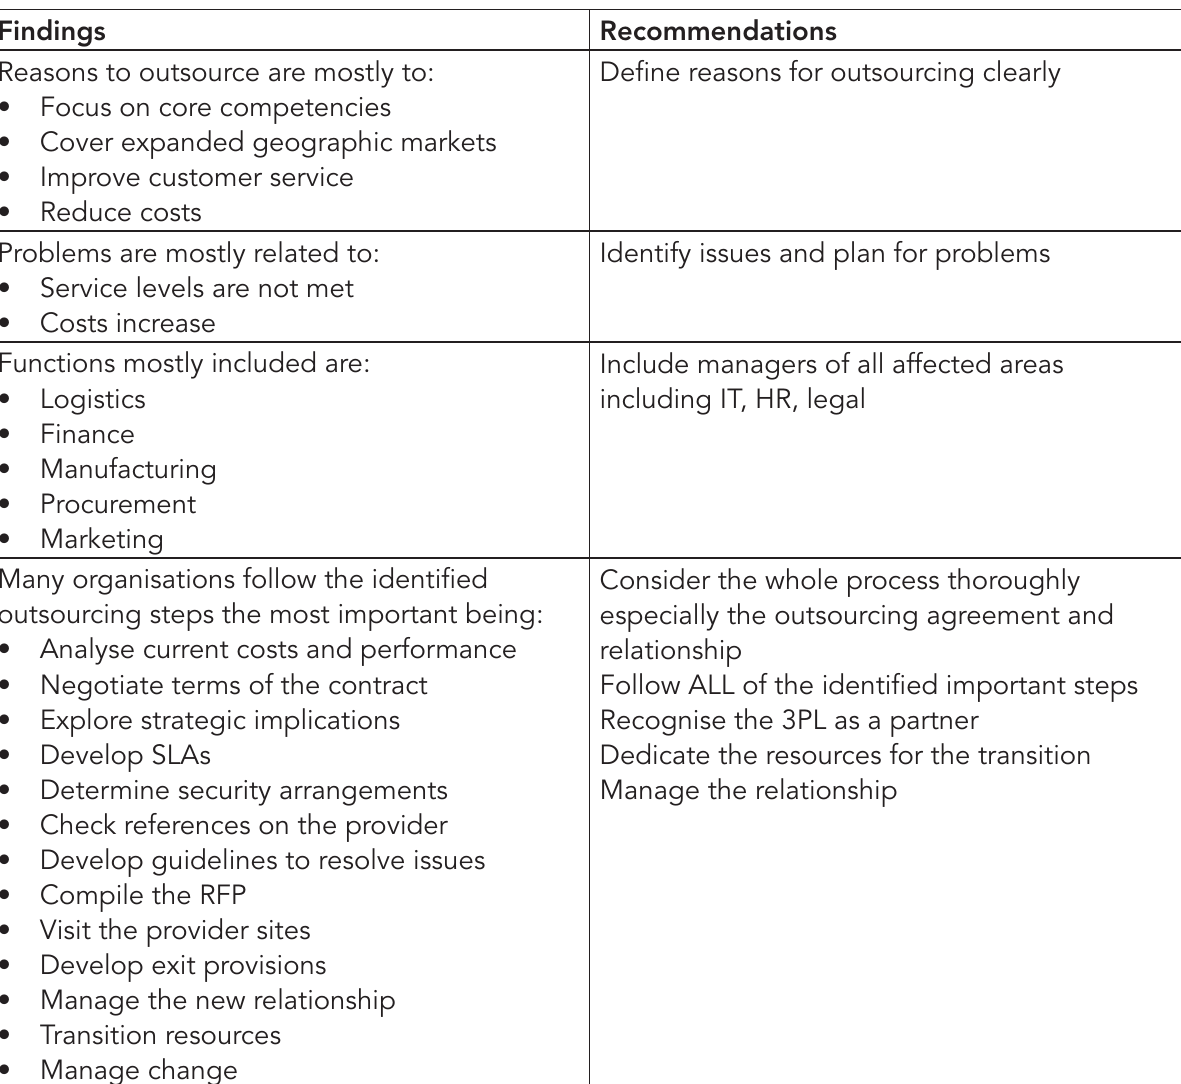
Table 1: Summary of findings and recommendations Findings